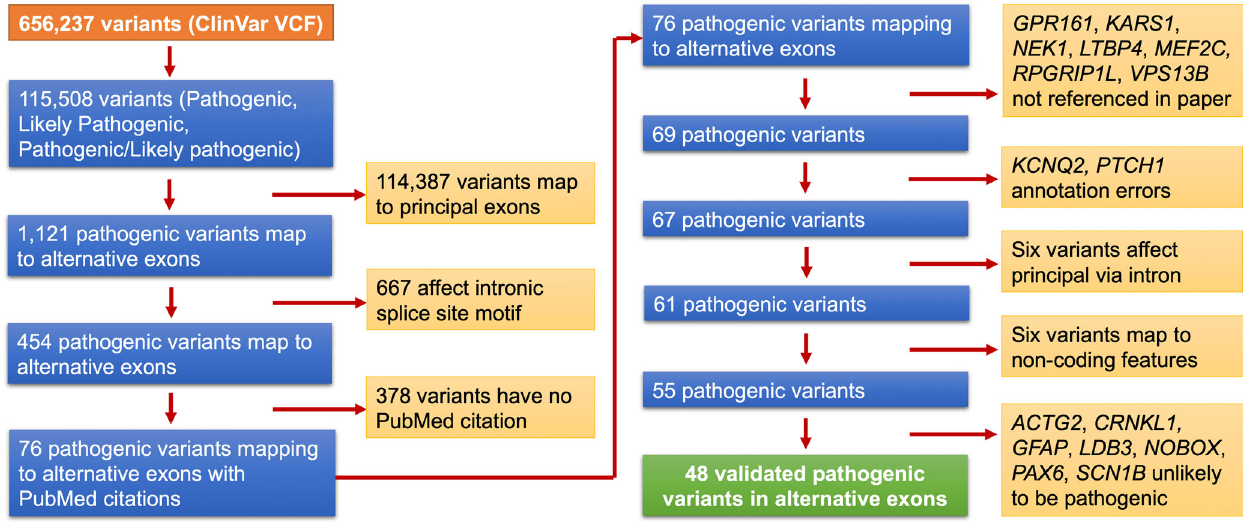
Fig. 3 The process of validating the pathogenic variants that map to alternative exons. The process of mapping pathogenic variants from the ClinVar VCF fi le (version 4th April 2021) to the APPRIS principal and alternative transcripts (left side of the fl ow chart), and the breakdown of the manual analysis of the 76 pathogenic variants that map uniquely to APPRIS alternative variants (right side of the chart). We found that just 48 pathogenic variants had a direct effect on the expressed alternative protein. We tagged these pathogenic variants as “ validated ”